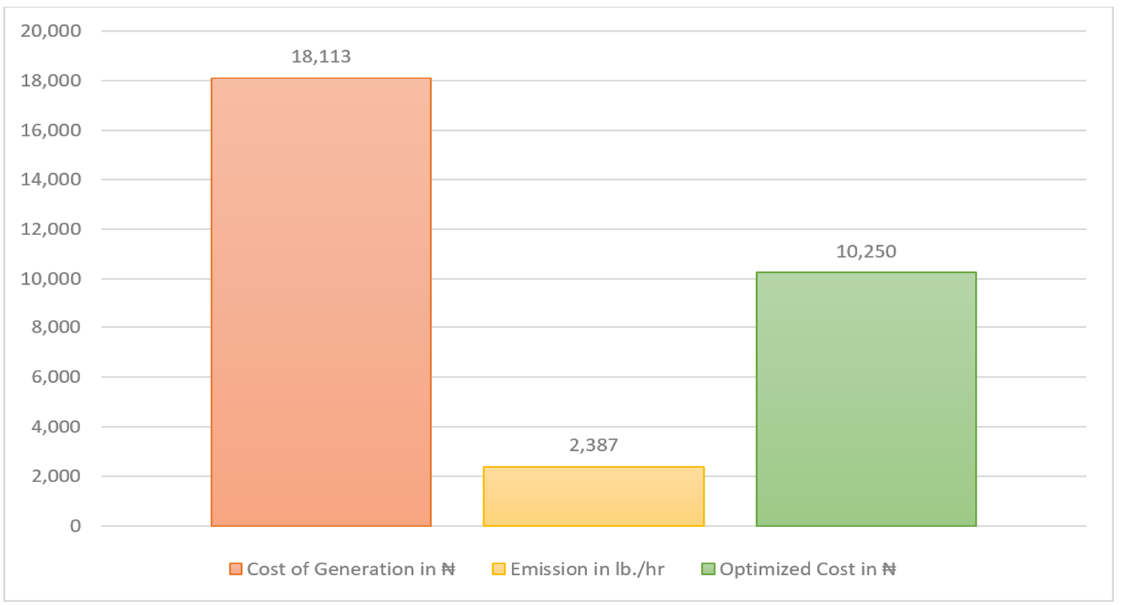
Figure 8. Case 3: Performance evaluation of economics and emissions.